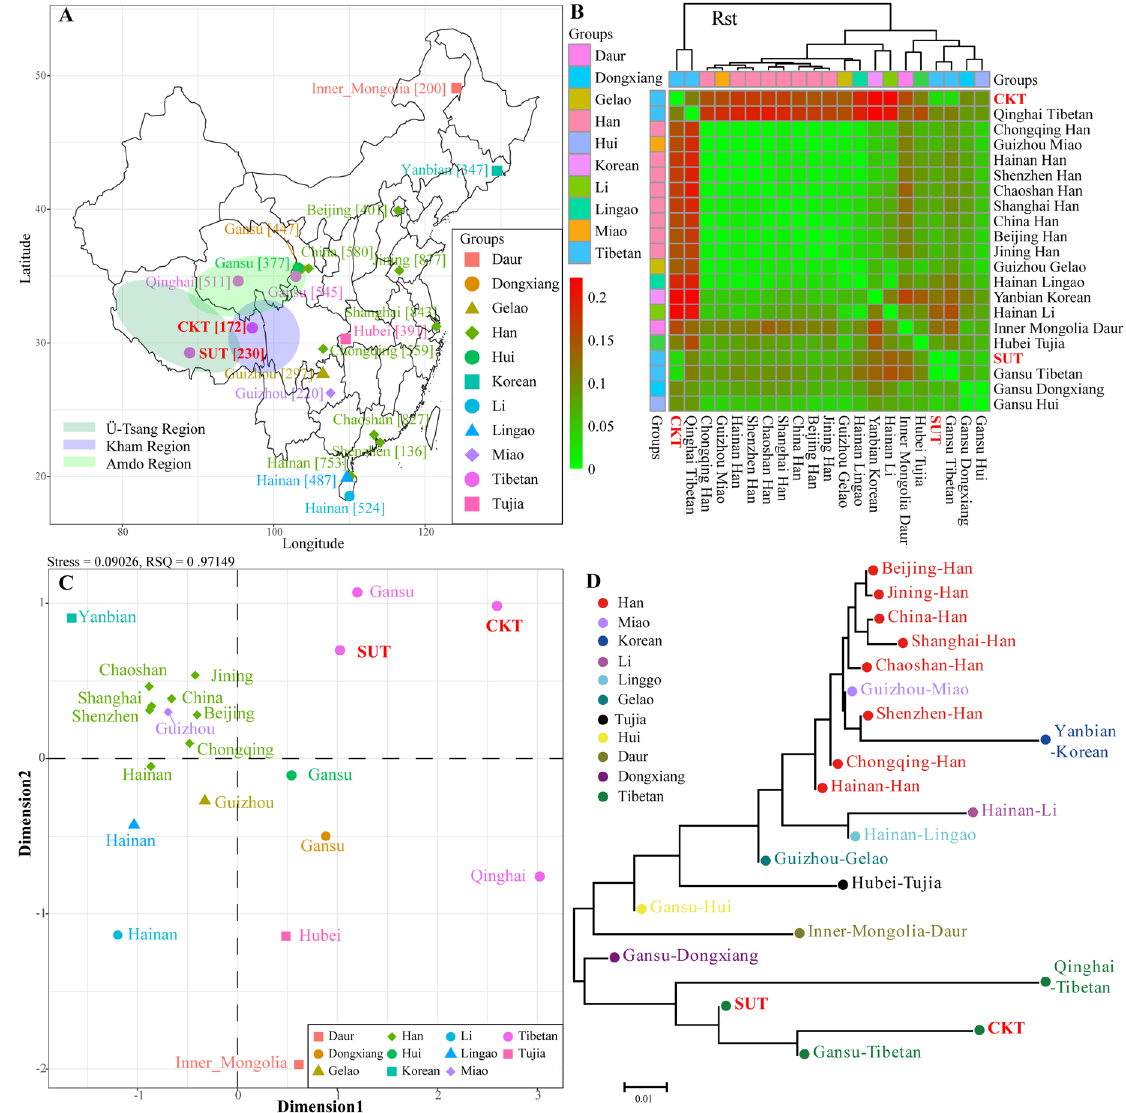
Figure 5. Genetic similarities and differences between two newly investigated Tibetan populations and 19 Chinese reference populations. ( A ) Geographical positions of 21 Chinese populations and the Kham, Ando and Ü-Tsang regions. The map was generated by free software R 3.3.2 (https://www.R-project.org/) 49 with the scripts listed in Supplementary Note 2 and was then modified using Adobe Illustrator CS6 software. ( B ) The map displays the pairwise Rst standard genetic distance between SUT, CKT and 19 Chinese populations. ( C ) Genetic relationships were explored using two-dimensional scaling plots. ( D ) The phylogenetic relationship was investigated via a neighbor-joining